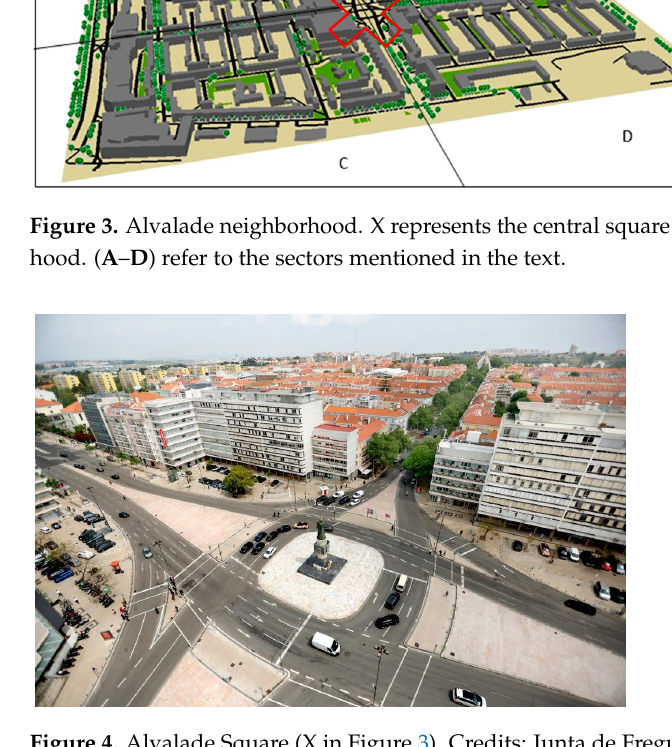
Table 1. Number of individuals per age group in the Alvalade Civil Parish, in 2011 and 2021.